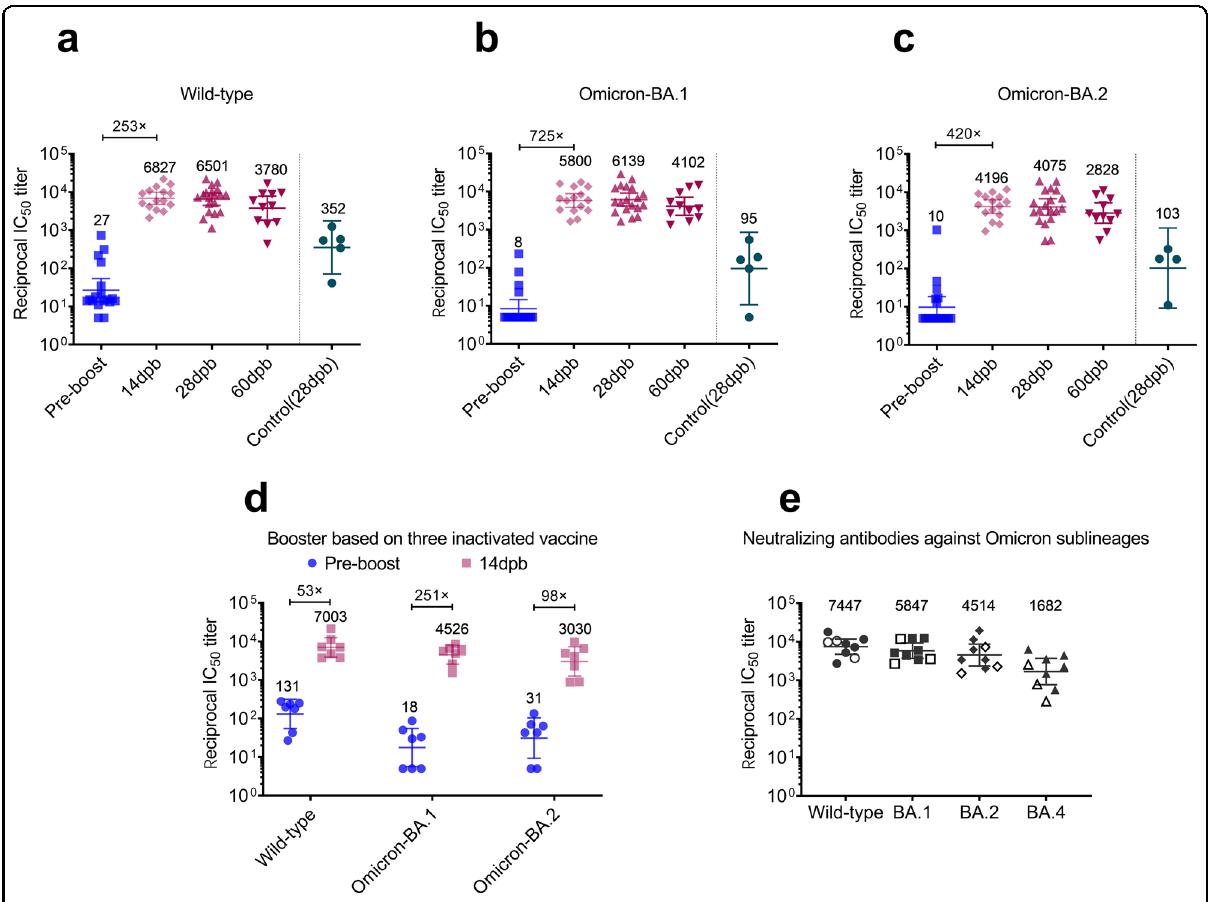
Fig. 5 Booster immunization with LyomRNA-Omicron could elicit high titers of neutralizing antibodies in humans. a – c On the basis of two vaccinations of inactivated vaccine (at least 6 months after the second dose), a booster shot with LyomRNA-Omicron was administered. Then, the titers of neutralizing antibodies against the wild-type ( a ), Omicron-BA.1 ( b ), and Omicron-BA.2 ( c ) pseudoviruses were detected at D0 (pre-boost), 14 dpb, and 60 dpb. Plasma pseudovirus-neutralizing antibodies in the control group were detected one month after the third homogeneous booster shot with inactivated vaccine. d A fourth booster with LyomRNA-Omicron was given on the basis of three immunizations with inactivated vaccine (at least 2 months after the fi nal dose), and then the titers of plasma-neutralizing antibodies against the wild-type, Omicron-BA.1, and Omicron-BA.2 pseudoviruses at 14 dpb were detected. e The titers of plasma neutralizing antibodies against Omicron 14 days after LyomRNA- Omicron booster immunization (nine serum samples were selected randomly for pseudovirus neutralization assay of Omicron, three of which boosting on three-dose inactivated vaccine are shown as empty dots, and six of which boosting on two-dose inactivated vaccine are shown as fi lled dots). Data are presented as the geometric means ± 95% con fi dence